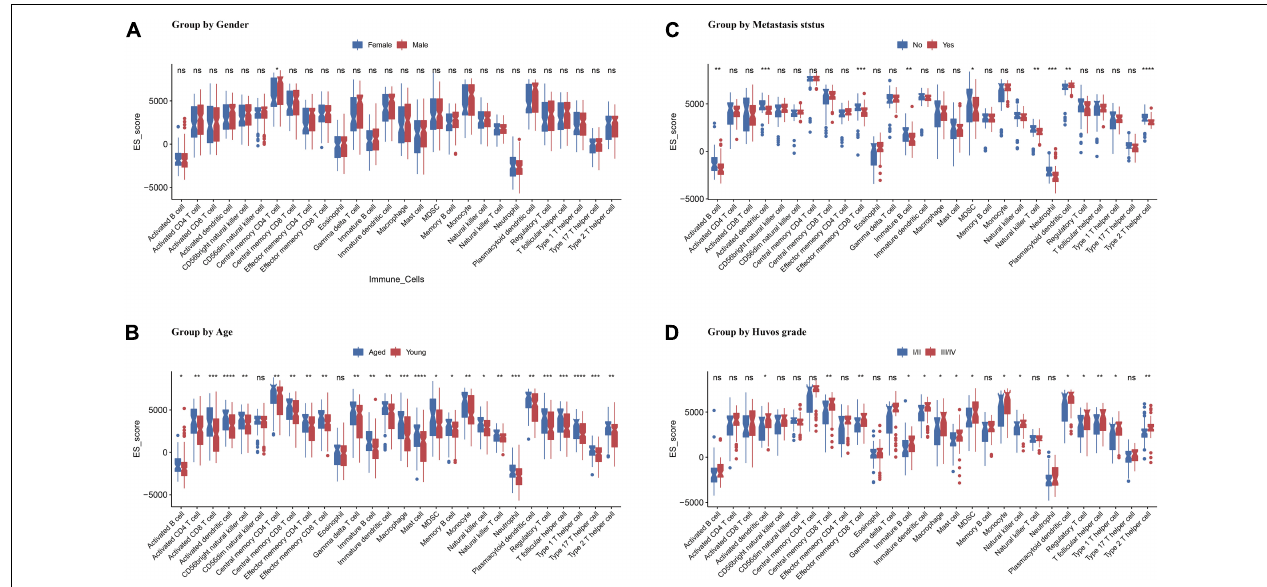
FIGURE 6 | Association of ES score with OS patients’ gender (A) , age (B) , metastasis status (C) , and Huvos grade (D) . Asterisk (*) denotes statistical significance examined by Student’s t -test. * p < 0.05; ** p < 0.01; *** p < 0.001; **** p < 0.0001; “ns” represents p >